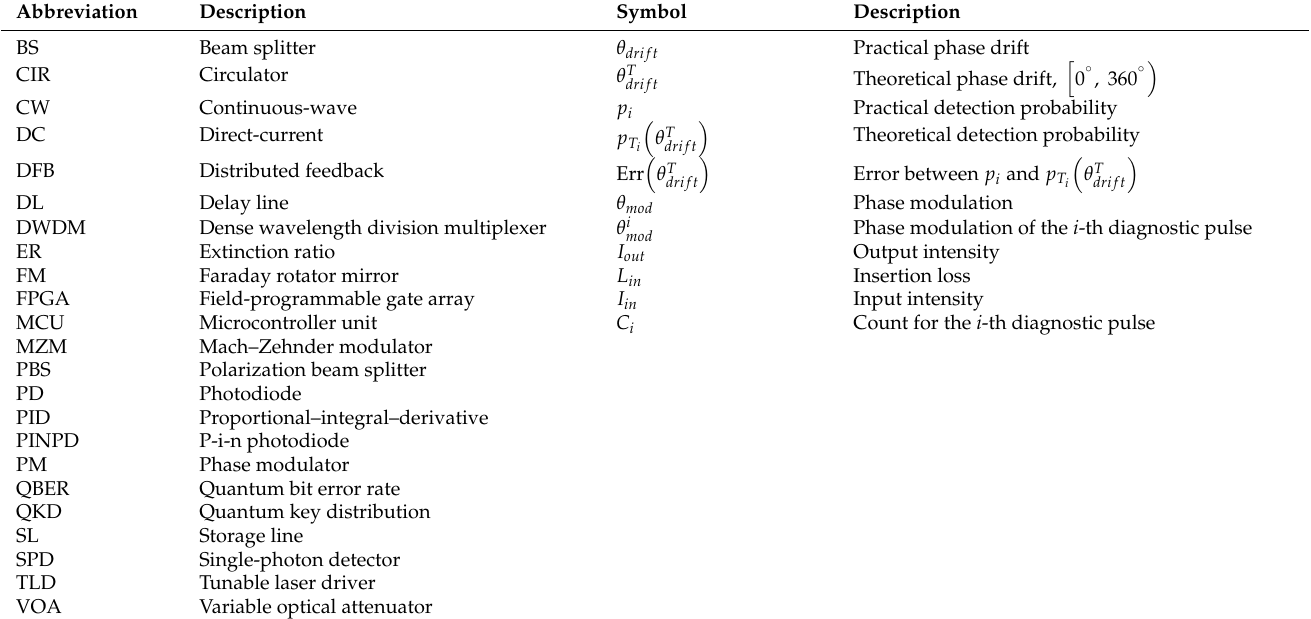
Table 1. Nomenclature of the symbols and abbreviations used in this